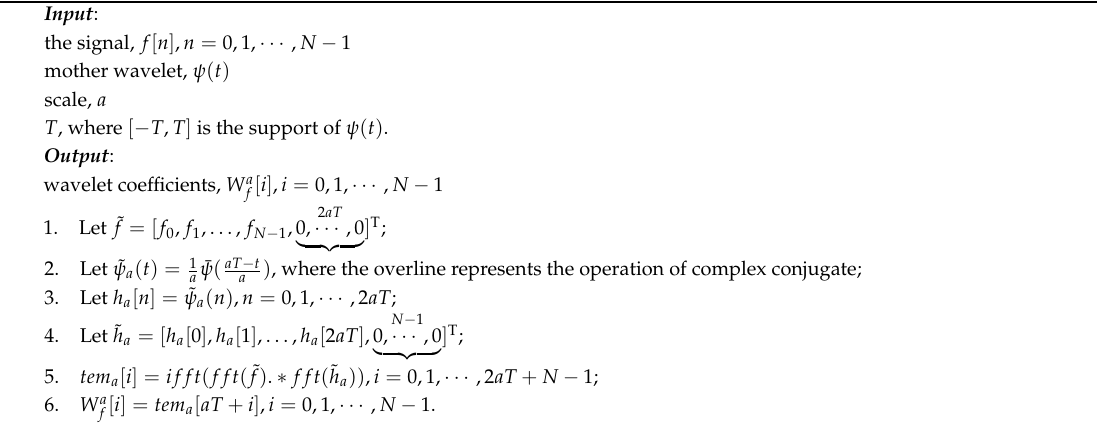
Algorithm 2: Time-domain fast algorithm for